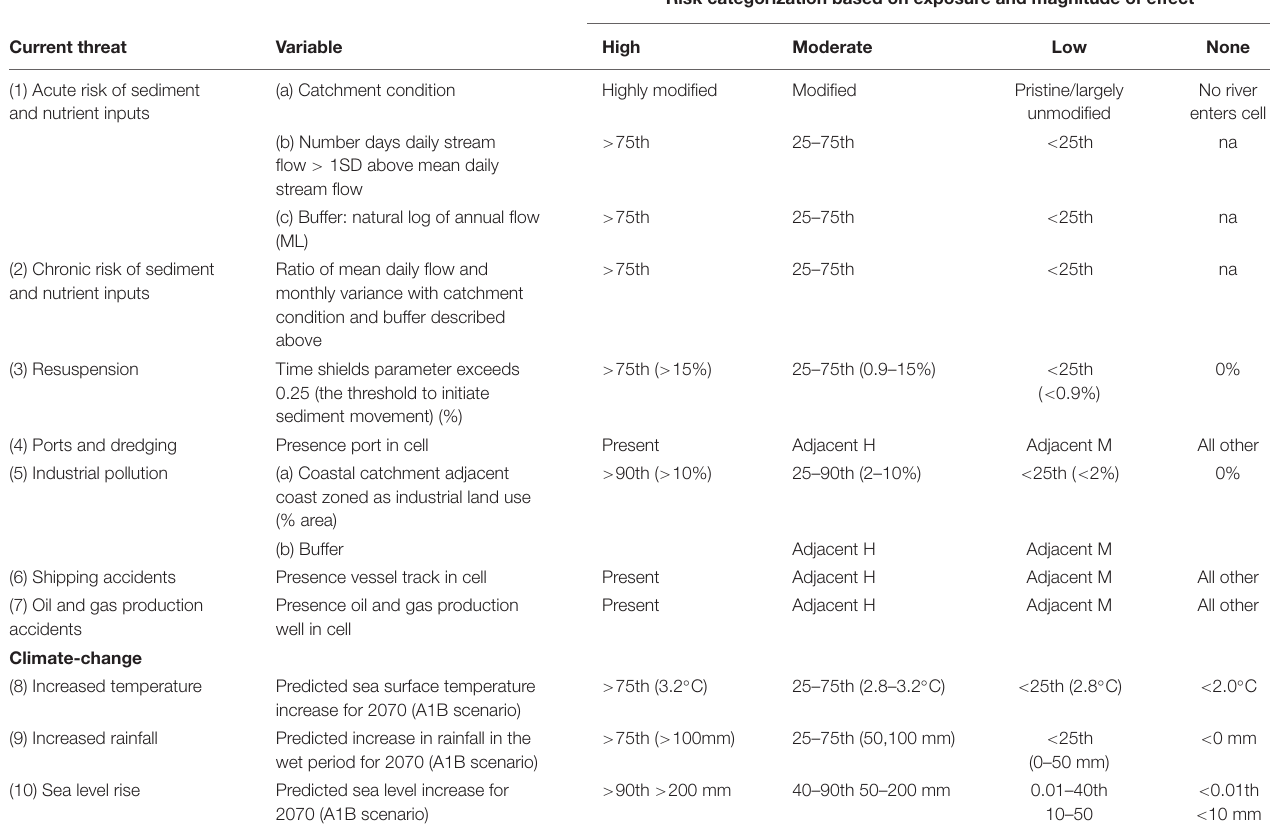
TABLE 1 | A summary of the threats included in the cumulative risk